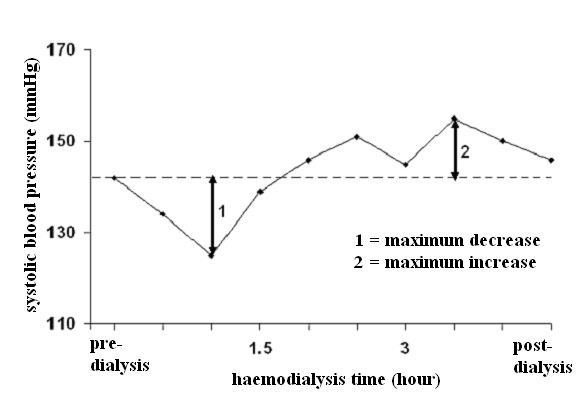
Evaluation of the fluctuations in haemodynamic parameters. Schematic representation of the method used to calculate the maximum increase and decrease of each measured parameter during the dialysis session.